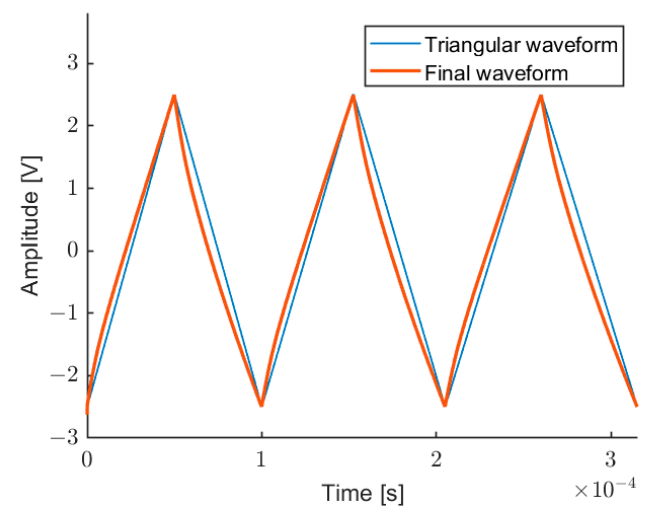
Figure 8. Output of the DAC, controlling the laser current generator, composed of waveforms at three frequencies (10 kHz, 9.5 kHz, and 9 kHz), after the pre-emphasis procedure (thick line) for getting a linear wavelength modulation, in comparison with the initial triangular modulation (thin line).